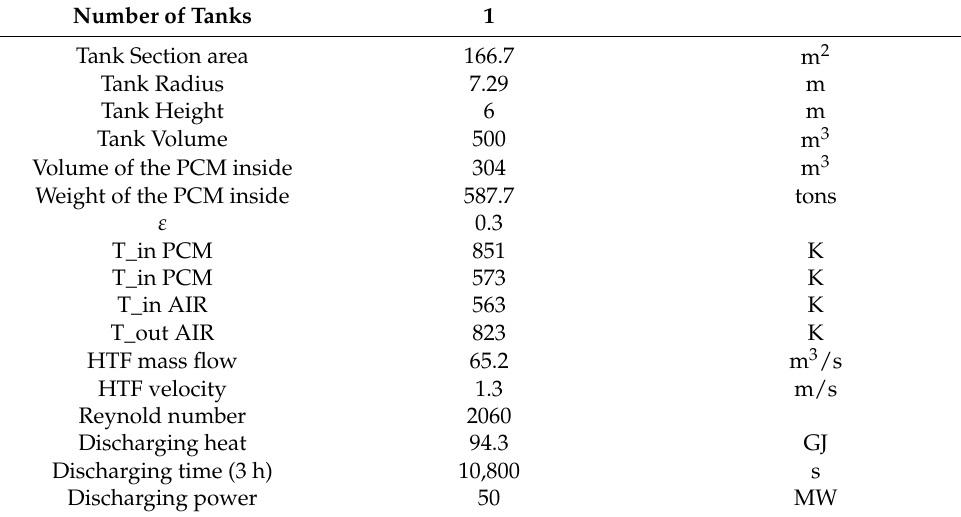
Table 7. Heat exchanger minimum size